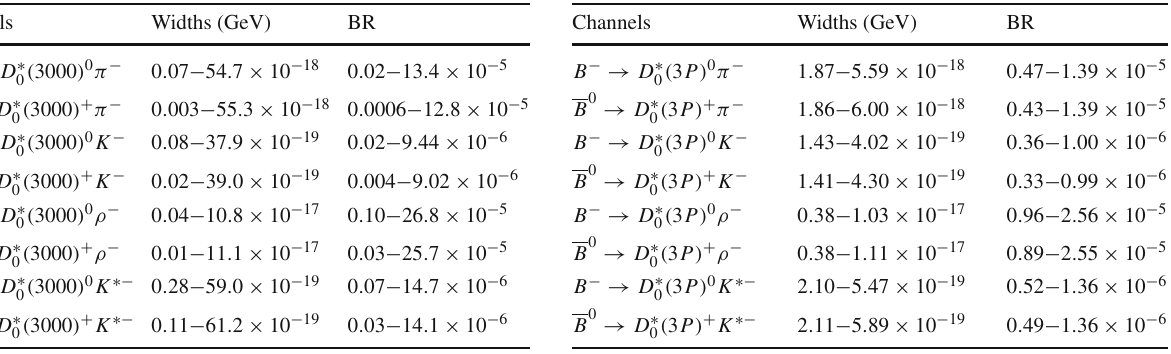
( 3000 ) Table 8 Non-leptonic production results of the 3 P state D ∗ 0